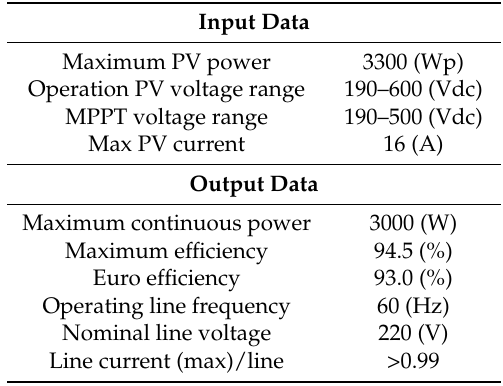
Table 3. Specifications of the power conditioning system. MPPT: maximum power point tracking.